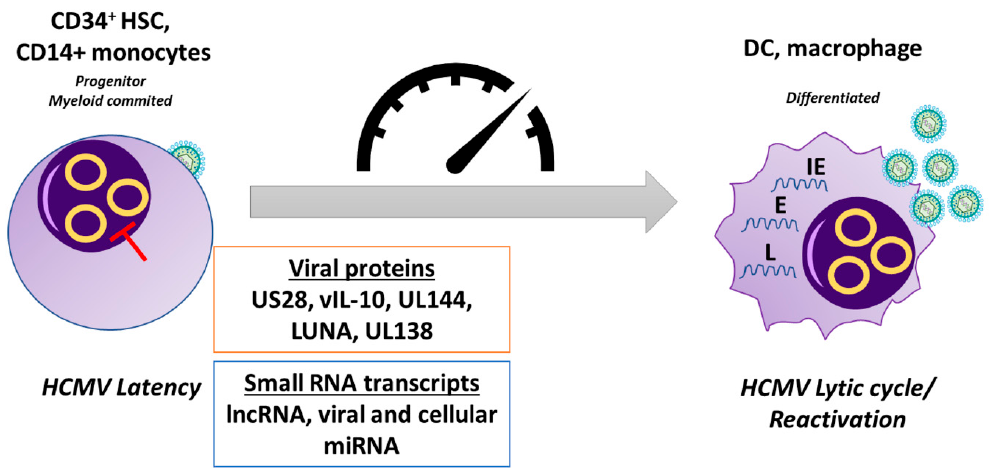
Figure 4. Latency. Following primary infection, HCMV can establish latency in CD34+ myeloid progenitor cells and is carried down the myeloid lineage. In latently-infected CD34+ cells and monocytes, there is a targeted suppression of lytic viral gene expression. HCMV utilizes several viral proteins and small RNA transcripts, including viral and cellular miRNAs, during latent infection to alter the signaling environment within the cell to maintain the status of latency. Di ff erentiation